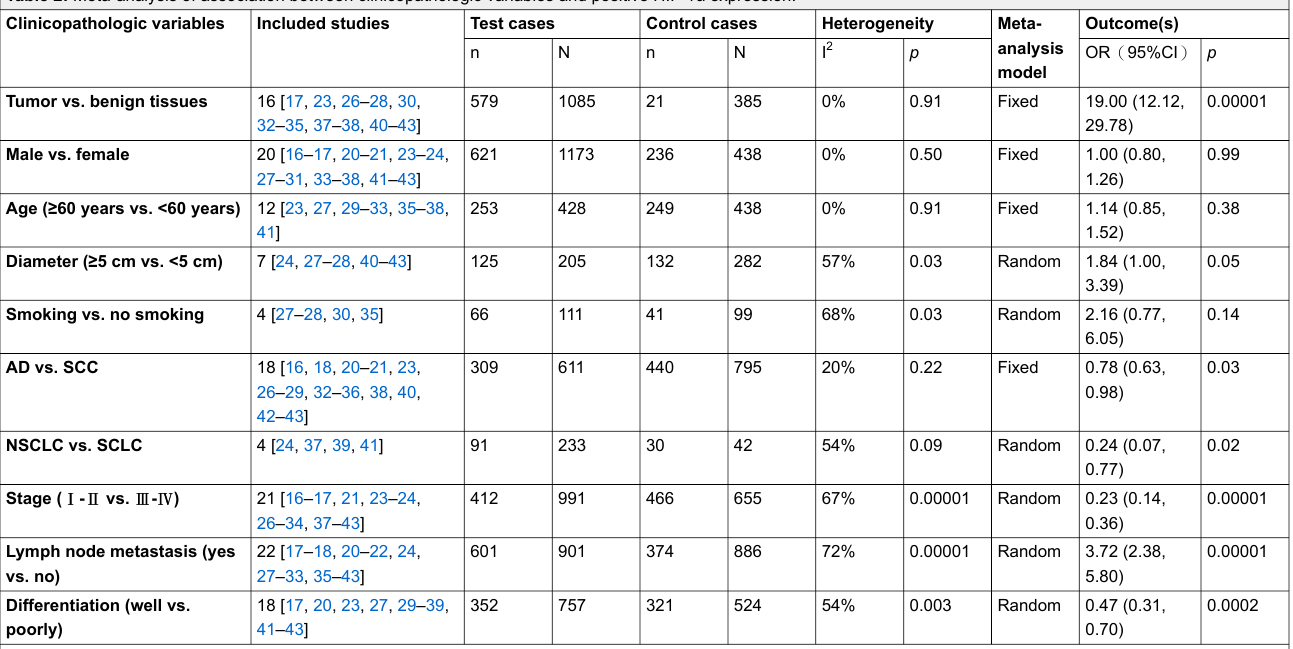
Table 2: Meta-analysis of association between clinicopathologic variables and positive HIF-1α